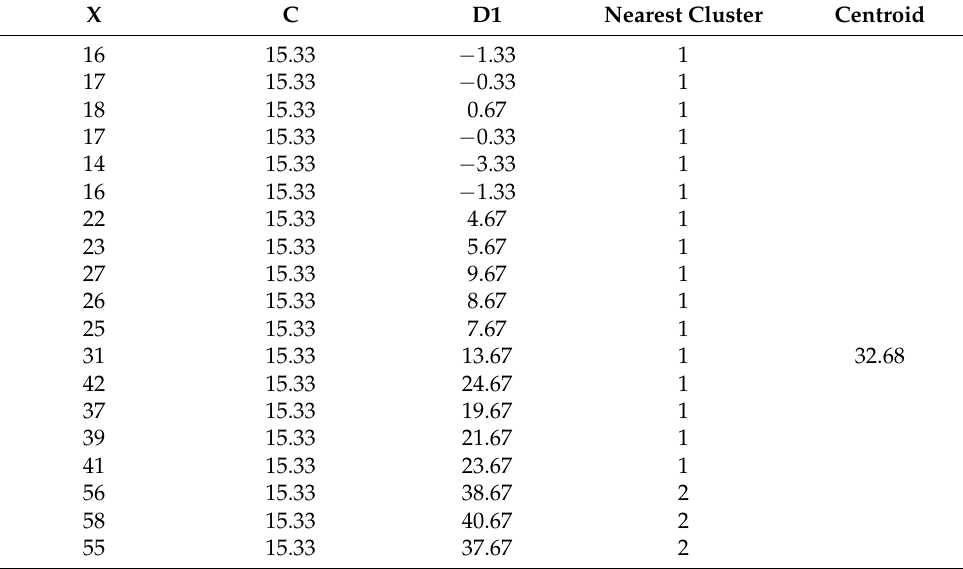
Table 3. Iteration 2—find the next closest centroid values of the nearest